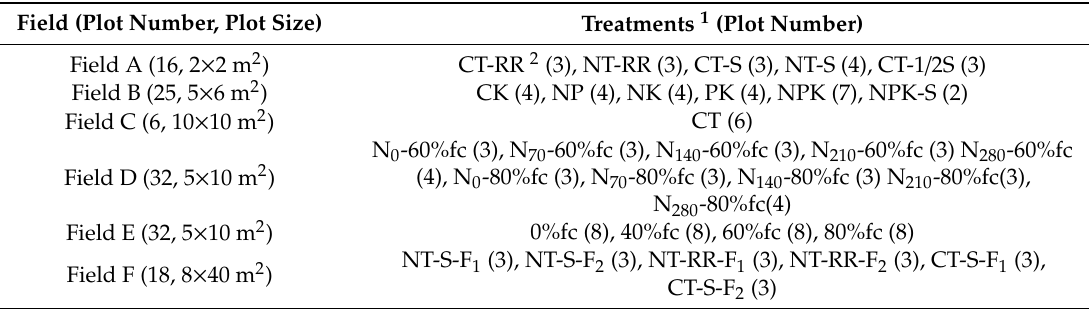
Table 2. Treatments of the six experimental